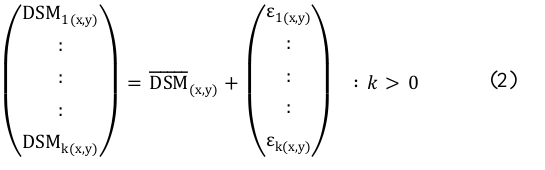
histograms discrepancy(m); WorldView-1 vs. CP